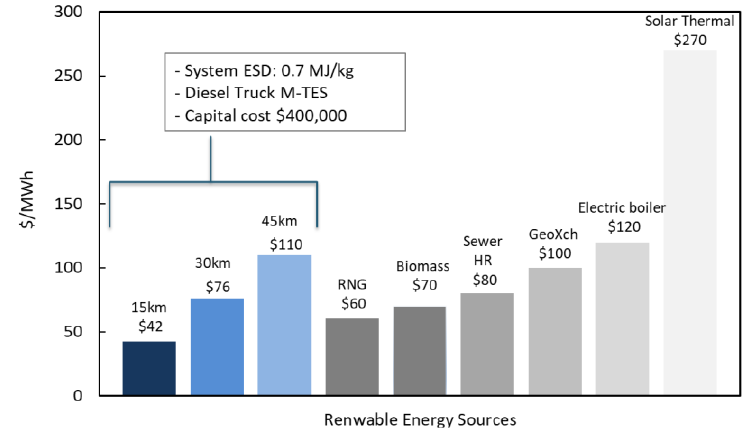
Figure 7. The levelized cost of diesel truck M-TES ($/MWh) varies with a distance and system ESD of 0.7 MJ/kg and other Surrey DEN low-carbon sources cost estimation.